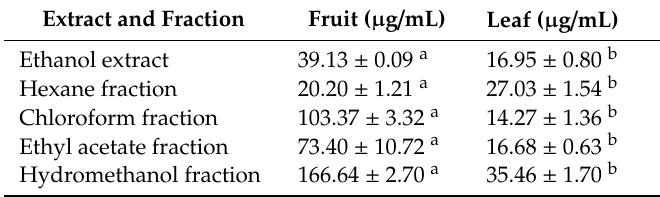
Table 4. Determination of antioxidant activity in vitro, CI 50 (50% inhibition values)data ( µ g / mL), by the DPPH (radical scavenging activity using DPPH (1,1-diphenyl-2-picrylhydrazyl) assay) method for extracts and fractions of fruits (peel, pulp, and seed) and leaves of Garcinia gardneriana . Extract and Fraction Fruit ( µ g / mL) Leaf ( µ g / mL) Ethanol extract 39.13 ± 0.09 a